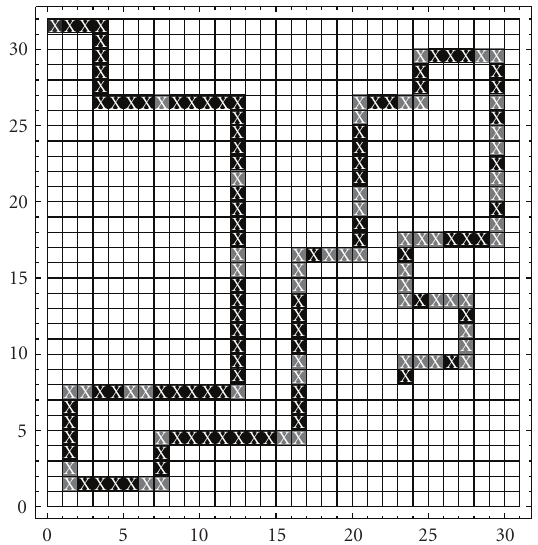
Figure 12: Santa Fe Trail overcome by ant found by